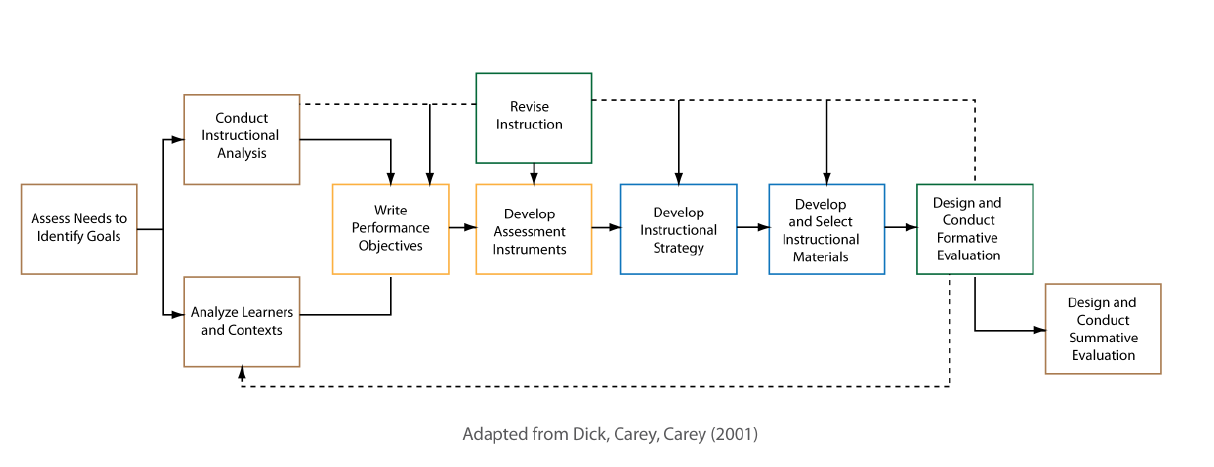
Figure 2. The Dick and Carey Systems Approach Model for Designing